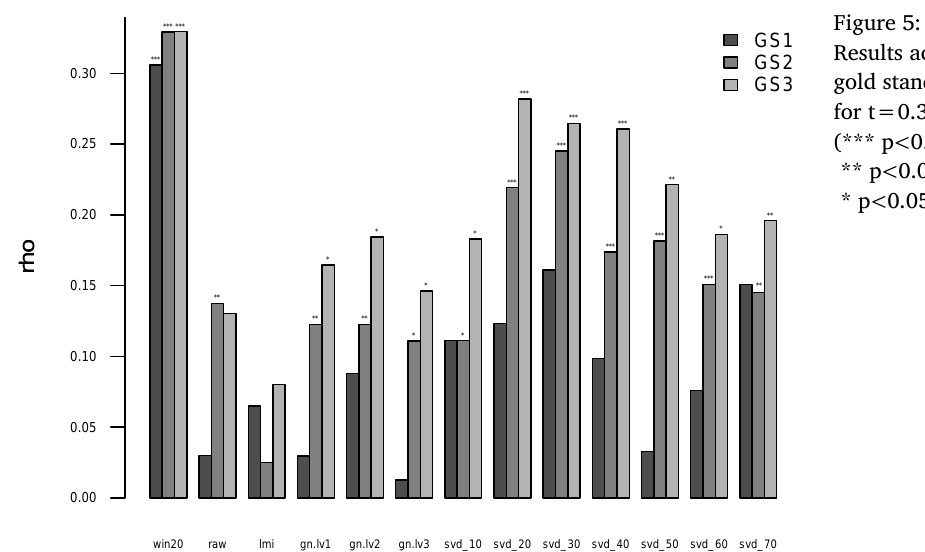
Results across gold standards, for